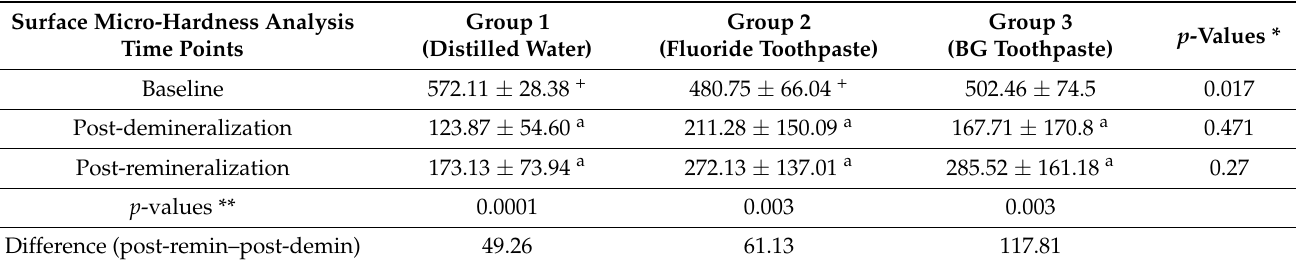
Figure 1. Vickers indentation executed to assess the micro-hardness of enamel surfaces. Table 1. Showing mean ± SD VHN for the three groups at different analysis time points.